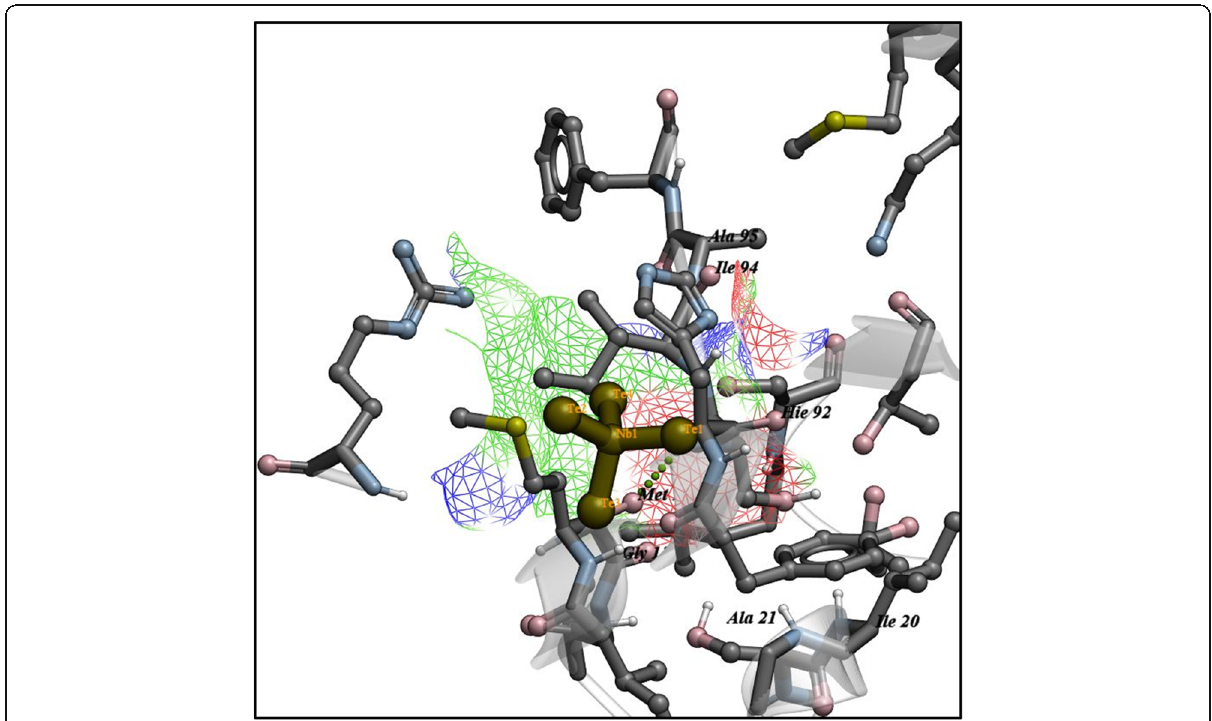
Fig. 12 Binding interaction pattern of NbTe 4 NPs with active site residues of enoyl-[acyl-carrier-protein] reductase (FabI) from S.